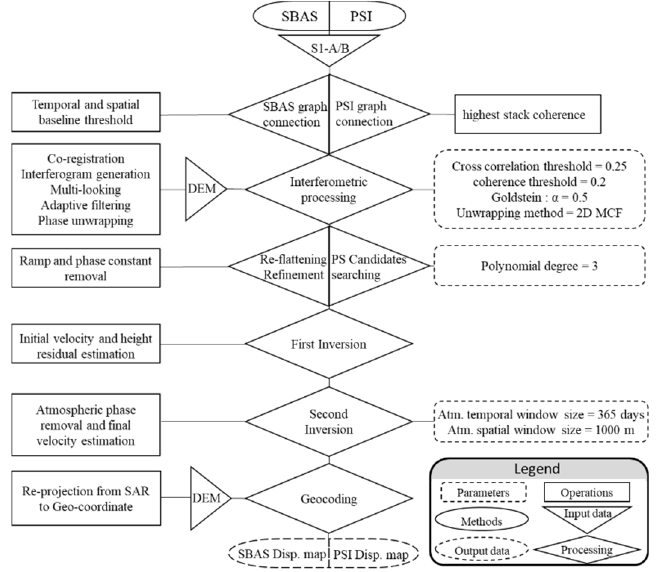
Figure 2. Workflow of the Small BAseline Subset (SBAS) and Permanent Scatterer Interferometry (PSI) processing in six